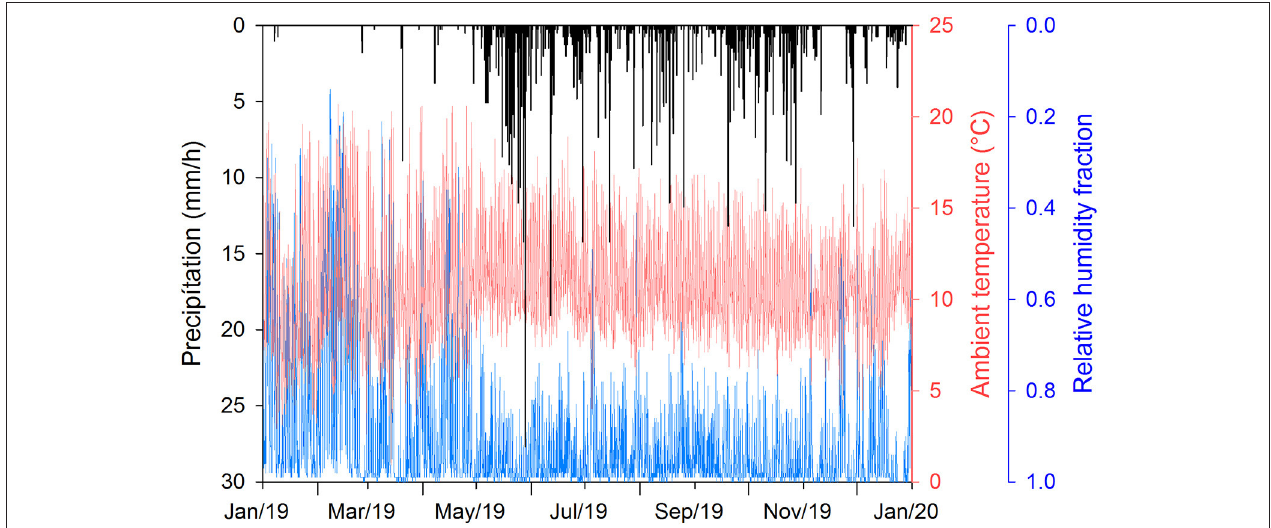
FIGURE 2 | Study area meteorological conditions during 2019. Black bars denote rainfall in mm/h. Red and blue lines correspond to hourly ambient temperature and relative humidity fraction, respectively.